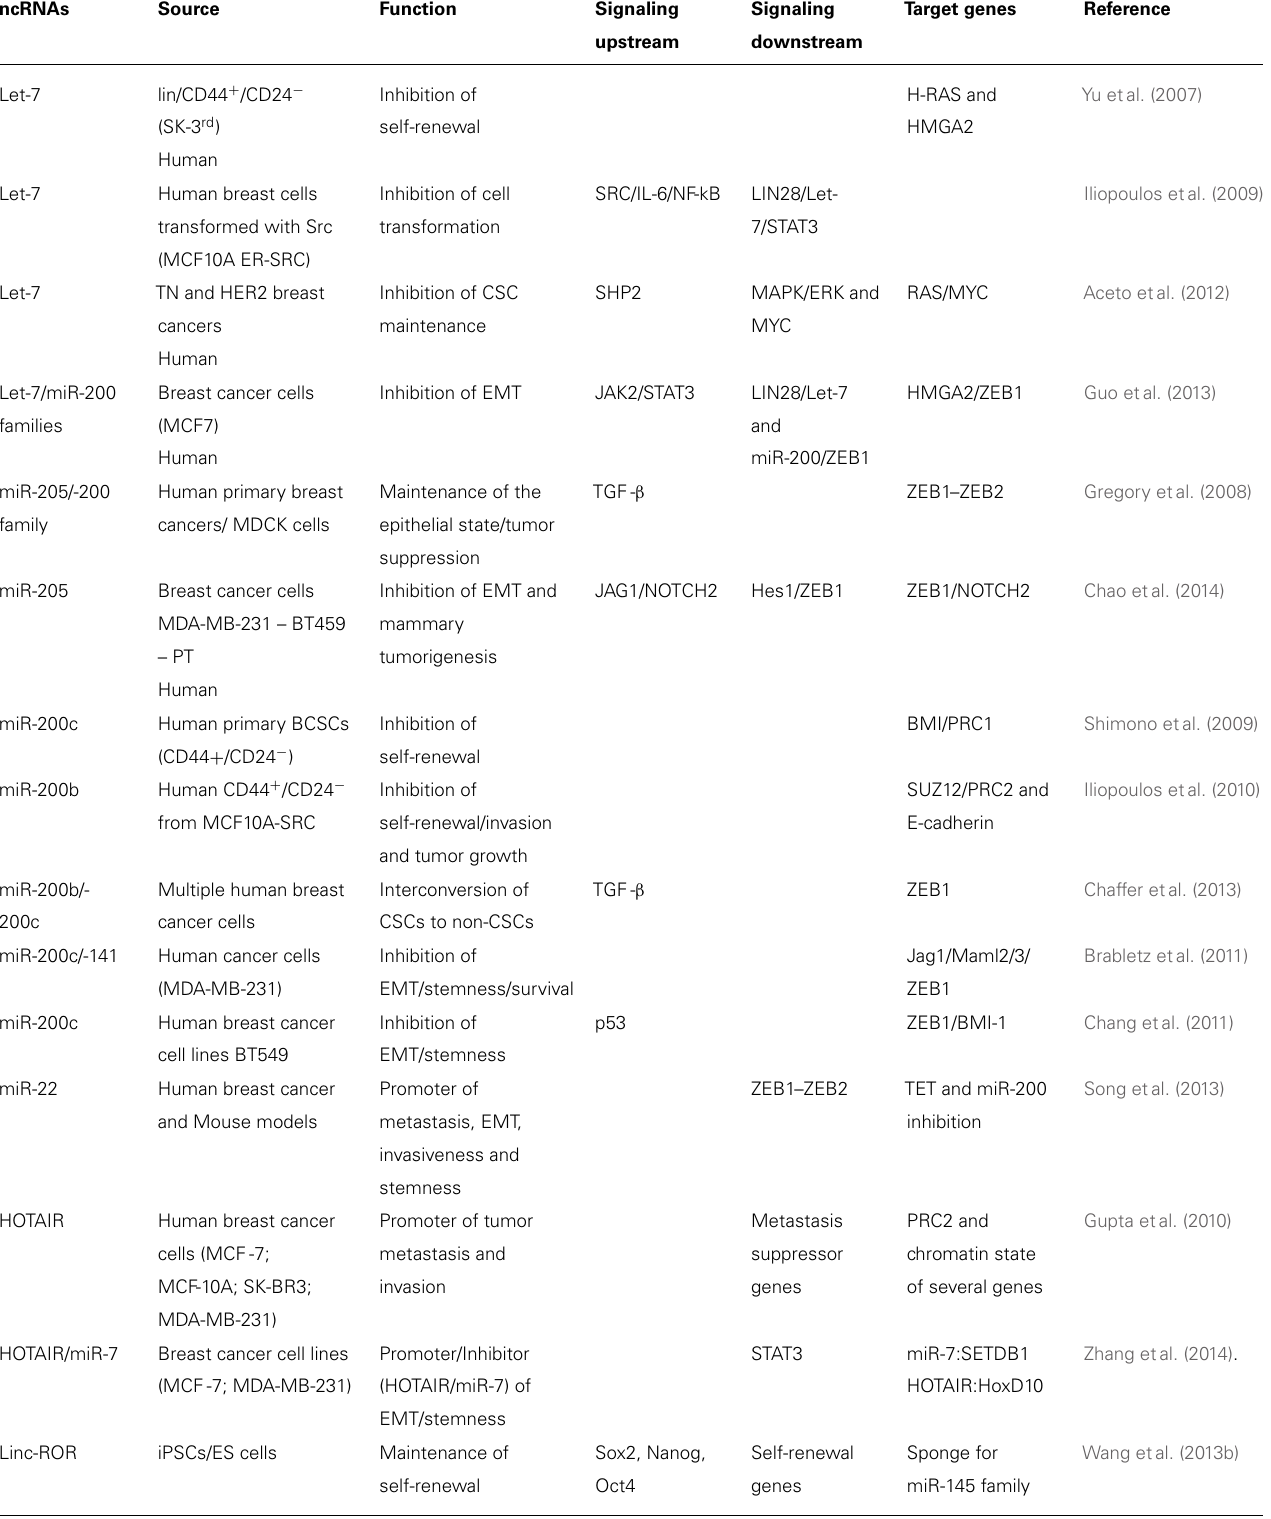
Table 2 | List of miRNAs and lncRNAs associated with breast cancer stem cells (CSCs).